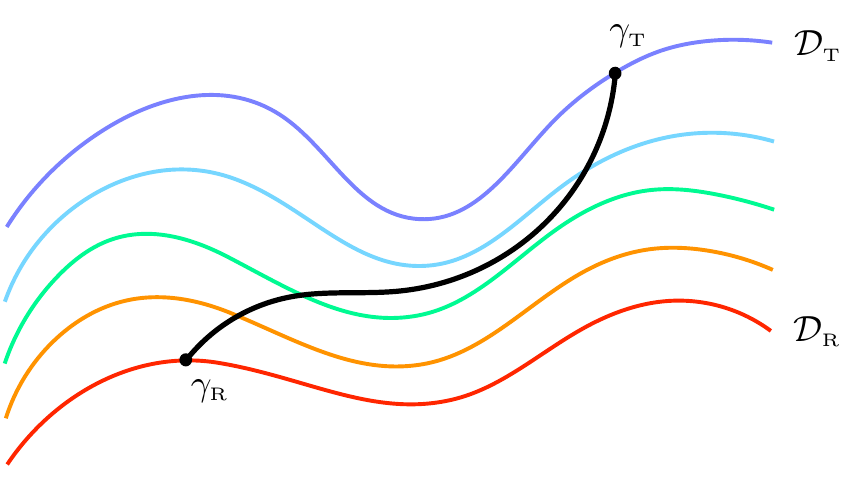
Figure 1 . Pictorial representation of the optimal circuit (2.28) connecting γ curve). Coloured solid curves represent the sets made by symmetric Gaussian matrices having the same symplectic spectrum. The red curve corresponds to D